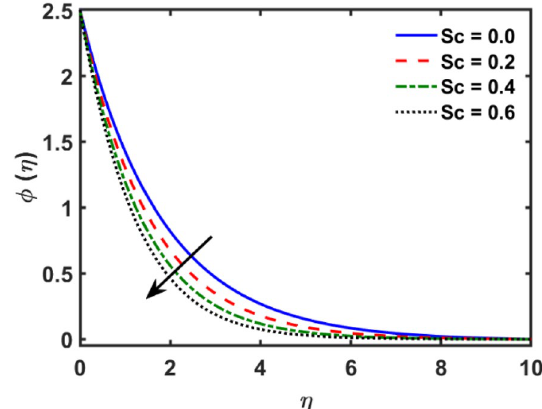
Figure 16. Variation of Sc on φ(η) .